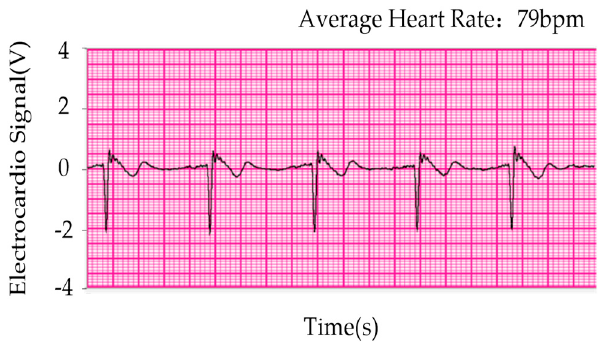
Figure 12. Electrocardio-signal recording.